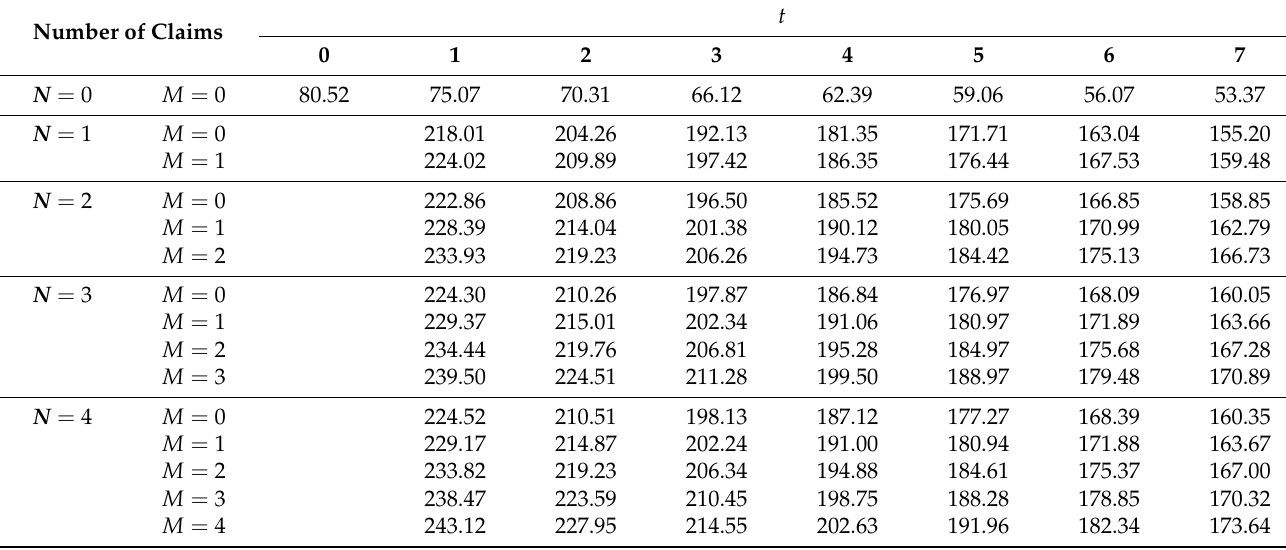
Table 7. Bonus-malus premiums based on Poisson binomial-Lindley beta distribution for the fre- quency component and gamma-Lindley distribution for the severity component with a total claim size of S = 2500.